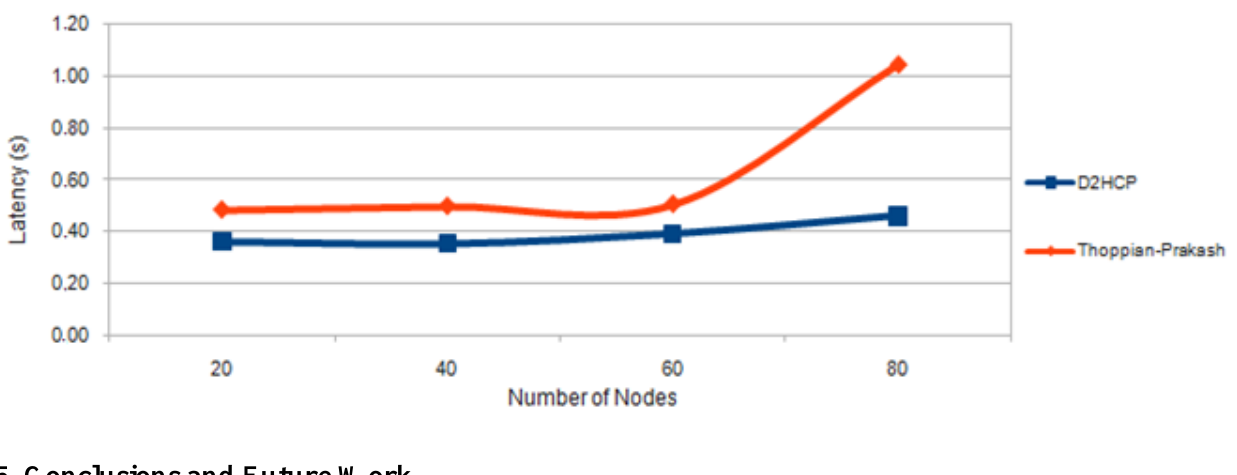
Figure 15. Latency D2HCP versus Thoppian and Prakash